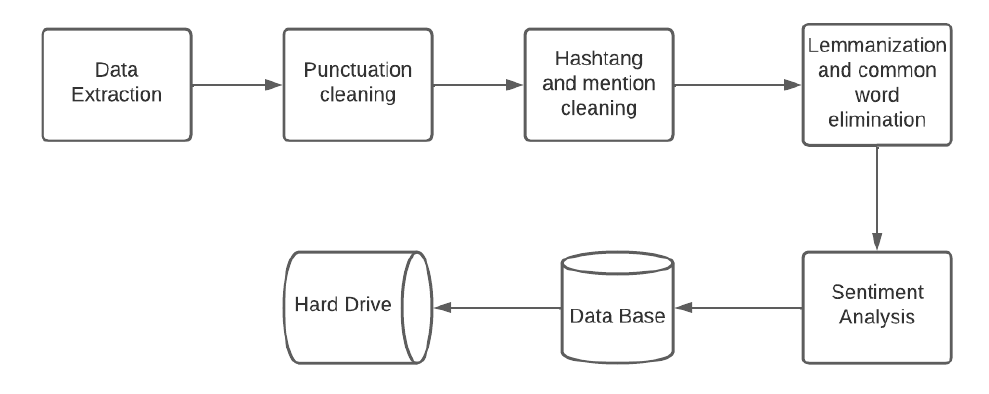
Figure 1. Number of tweets per month shows the total in thousands of